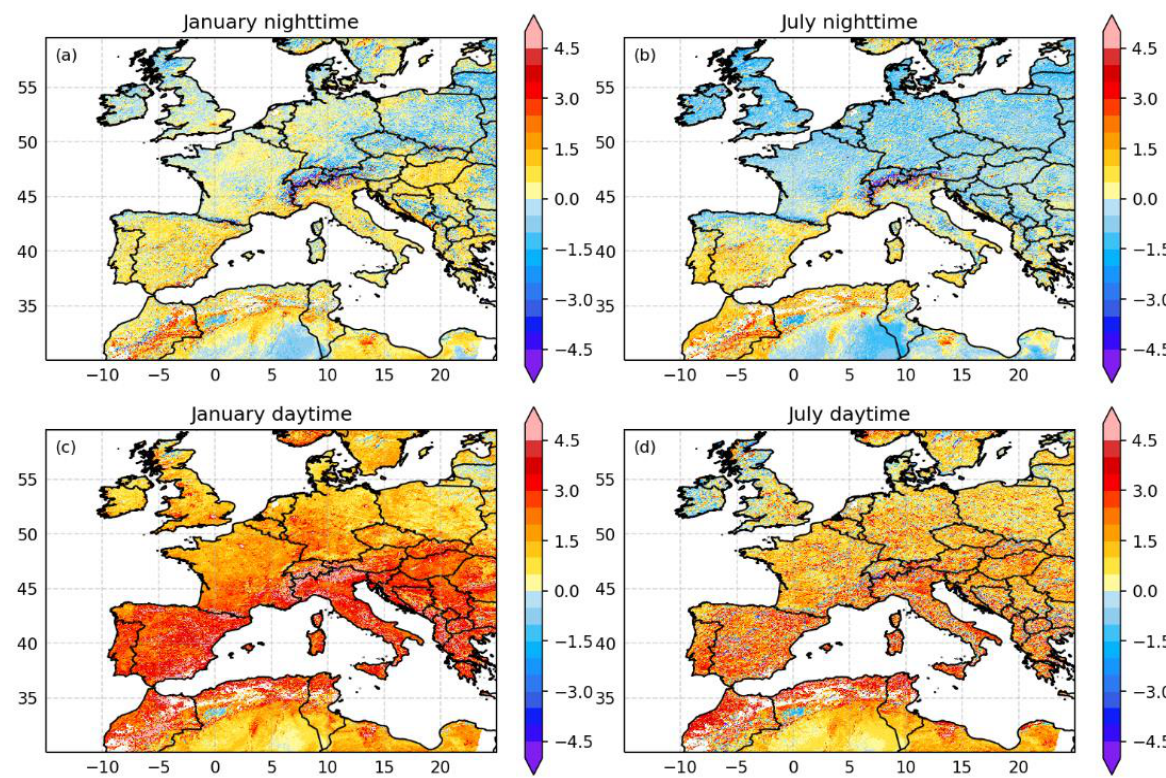
Figure 1. The median difference between MSG LST and MODIS LST (in K) for ( a ) January—nighttime; ( b ) July—nighttime; ( c ) January—daytime, and ( d ) July—daytime for the period between 2004 and 2015.